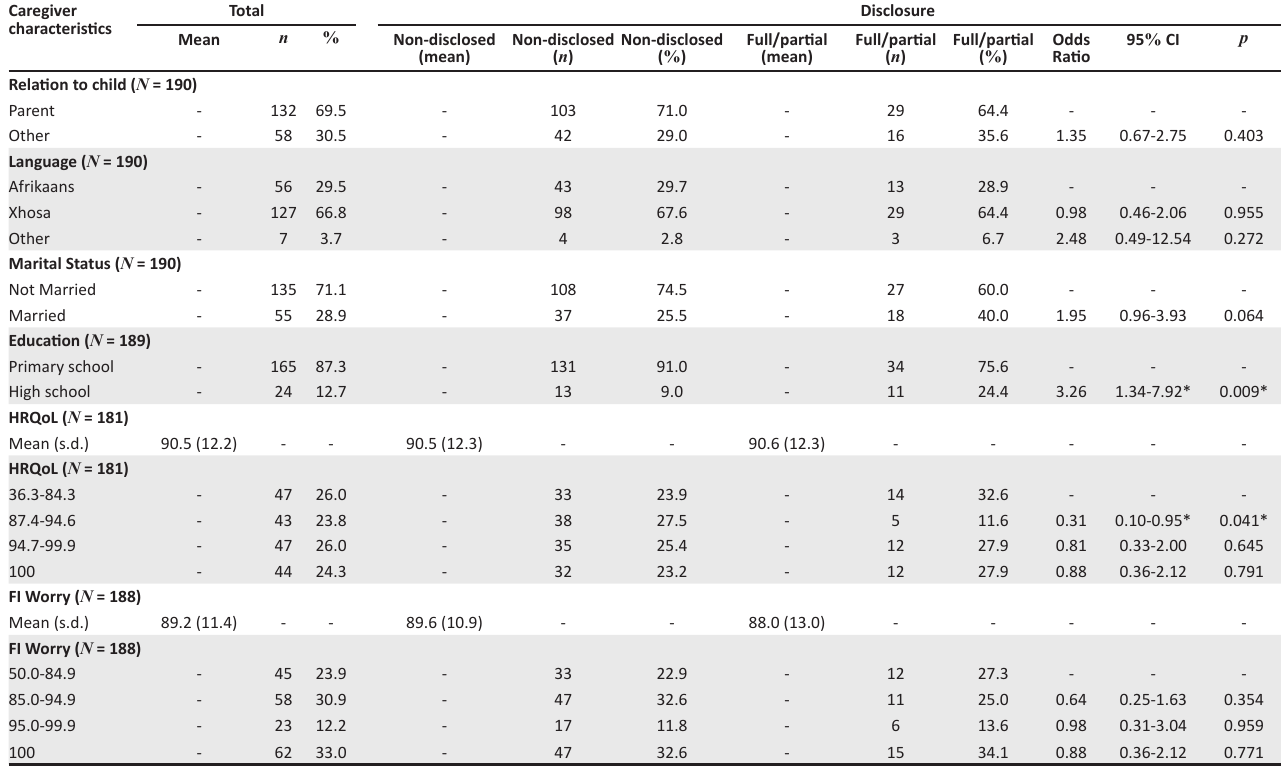
TABLE 2 (Continues...): Associations between disclosure and child characteristics – Univariate analyses. Caregiver